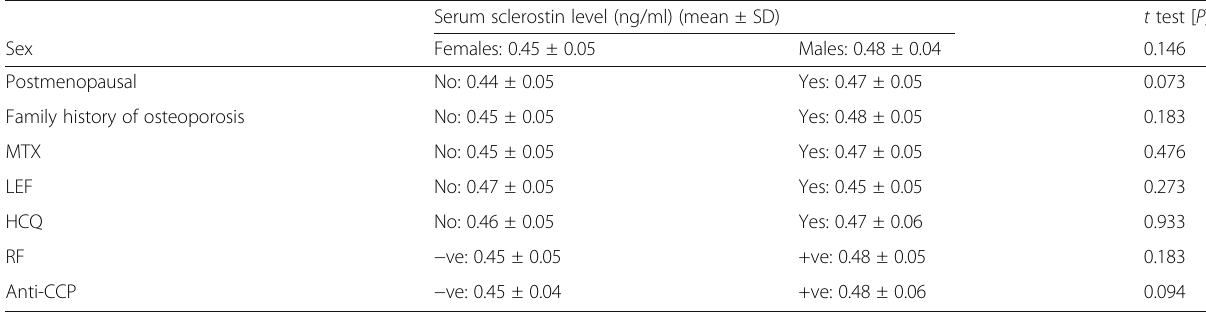
Table 4 The association of sclerostin serum level with sex, menopausal state, family history, drug intake, RF status, and anti-CCP status of RA patients